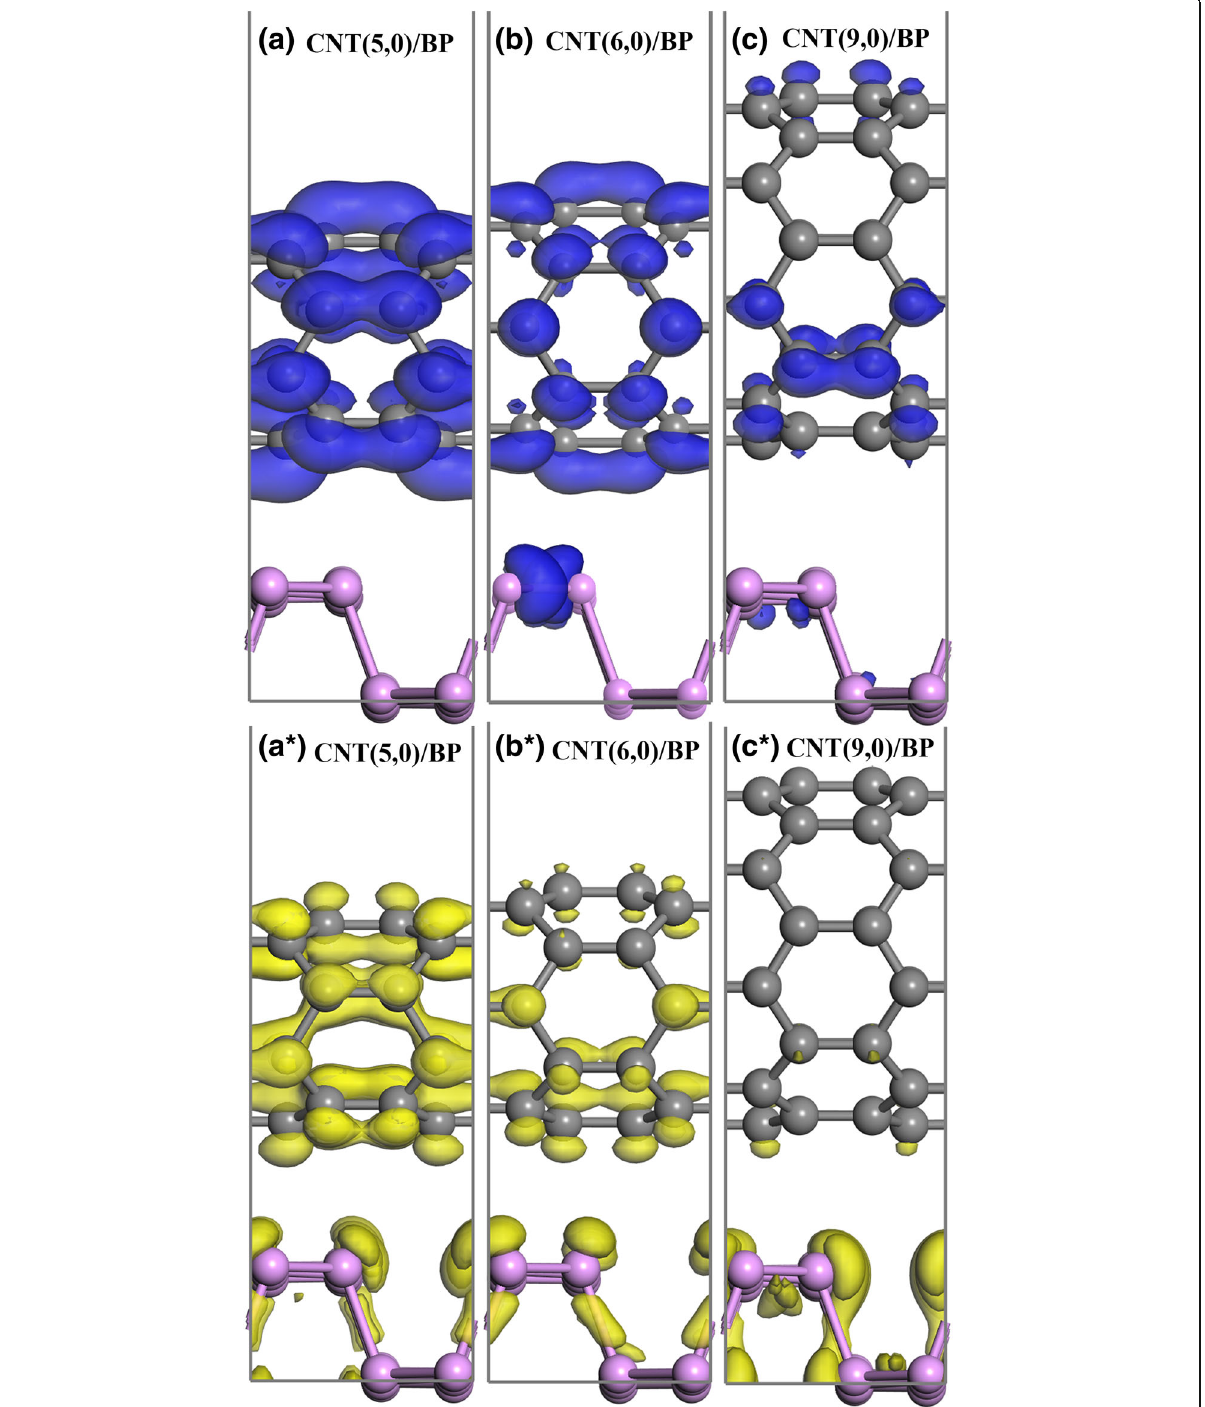
Fig. 4 Maps of the electron and hole density distributions for LUL ( a – c ) and HOL ( a * – c *) for the hybrid ( a ) CNT(5,0)/BP, ( b ) CNT(6,0)/BP, ( c ) CNT(9,0)/BP. The blue and yellow represent the electron and hole density distributions for LUL and HOL, respectively; the isovalue is 0.007 e/Å 3 . Herein, HOL and LUL are determined by the highest occupied and lowest unoccupied levels,